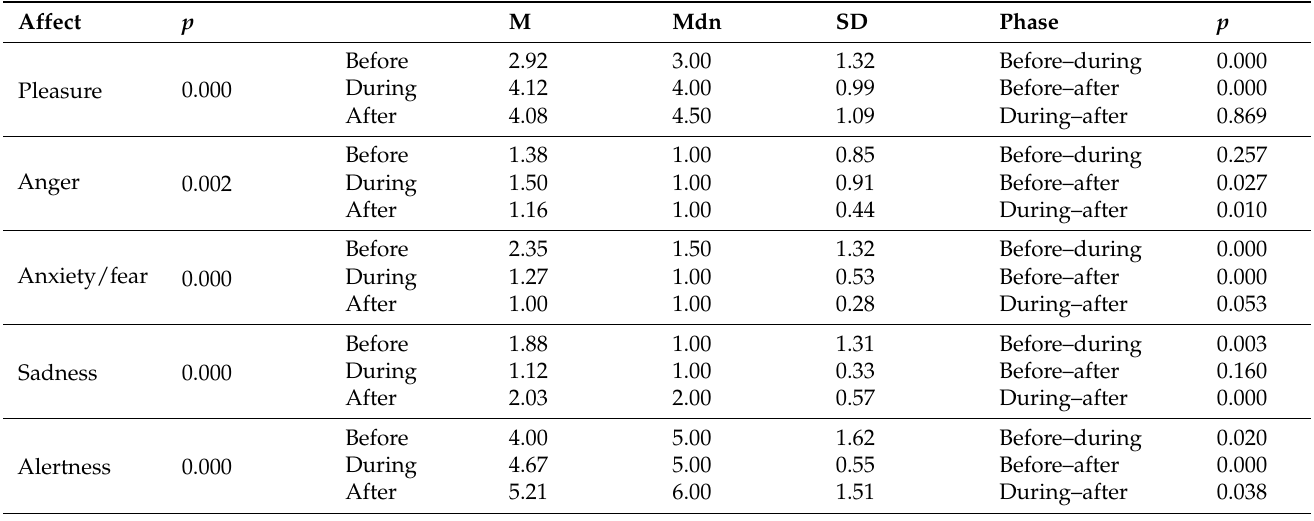
Table 1. Observed ratings of emotions before, during, and after VR exposure using OERS.